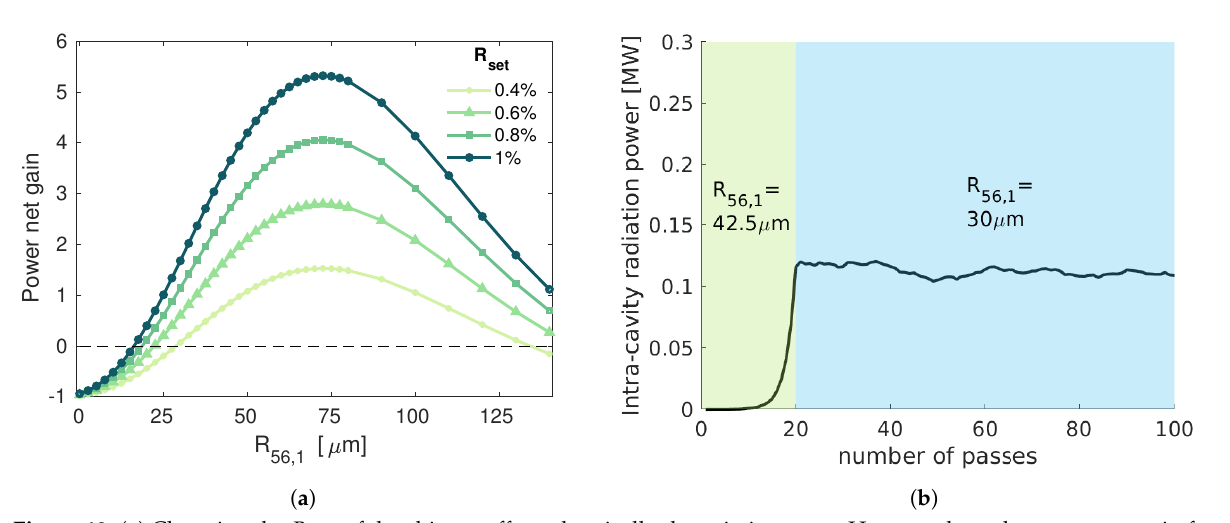
Figure 10. ( a ) Changing the R 56,1 of the chicane affects drastically the gain in power. Here we show the net power gain for selected set reflectivities R set , between 0.4% and 1%. The horizontal line shows the zero net gain. ( b ) With a reflectivity R set = 0.38%, it is possible to transition from positive gain to zero gain by adjusting the longitudinal dispersion of chicane1 as shown in Figure 8, from R 56,1 = 42.5µm to R 56,1 = 30µm,